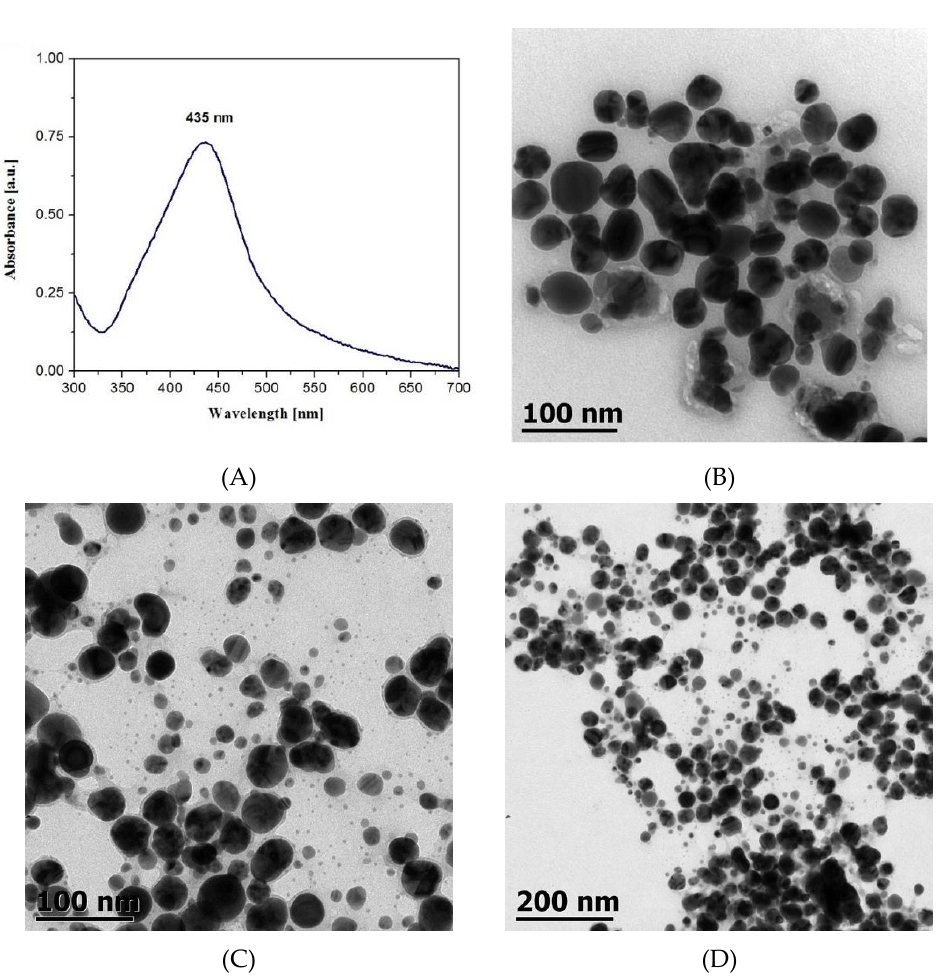
Figure 1. ( A ) UV-Vis extinction spectra of silver nanoparticles centered at 435 nm. ( B – D ) Representative micrographs of AgNPs synthesized using Geranium extract at a constant temperature of 85 °C.